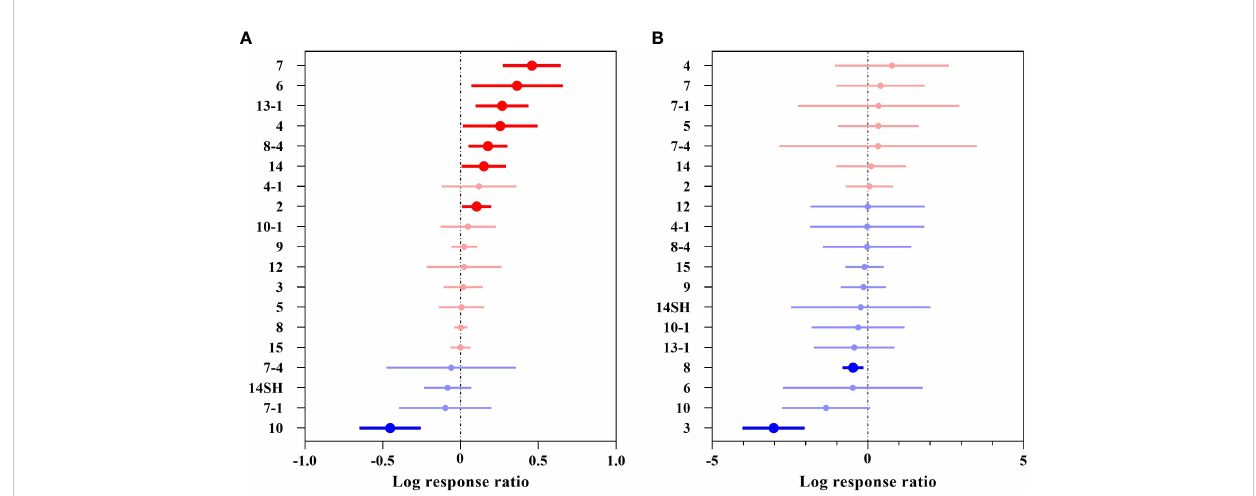
FIGURE 6 Effect sizes of different fl oristic regions of Chinese woody plants. (A) indicates the overall suitable area, and (B) indicates the highly suitable area. The effects of future climate on the overall/highly suitable area (main effects) for different woody plant fl oristic regions are indicated. Error lines